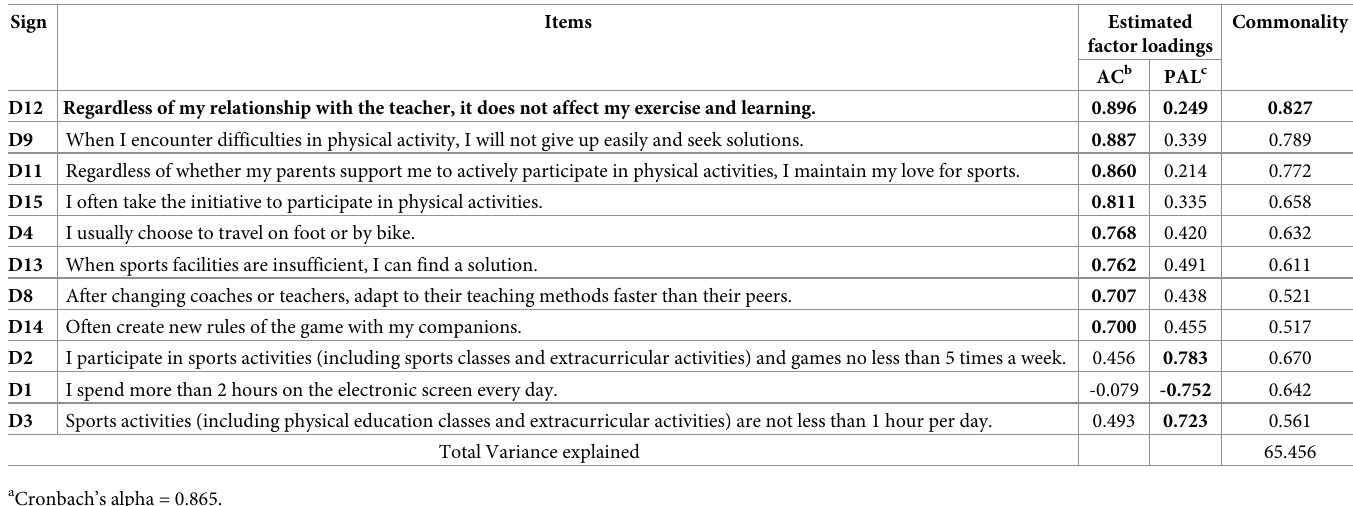
Table 10. Factor structures of behavior of physical activity by exploratory factor analysis a . Sign